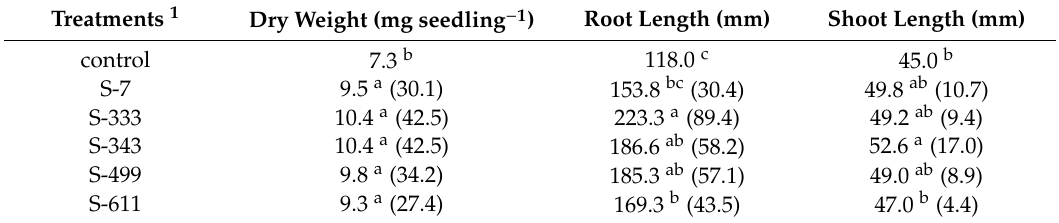
Table 2. Growth parameters of upland rice seedlings as a ff ected by bacterial inoculation. 1 Data were collected 14 days after